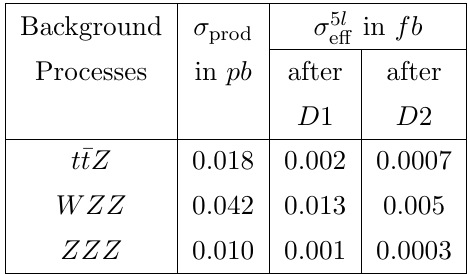
Table 17 . The production level and e(cid:11)ective cross-sections ( (cid:27) 5 l grounds.